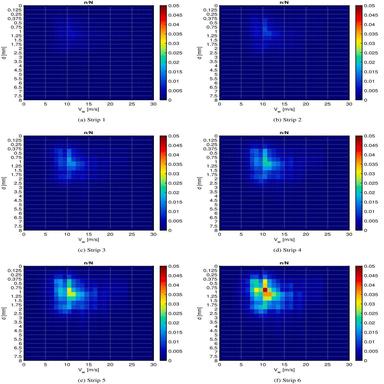
Maps of damage incubation fraction for six outermost blade strips after one year of operation predicted by reference erosion analysis.